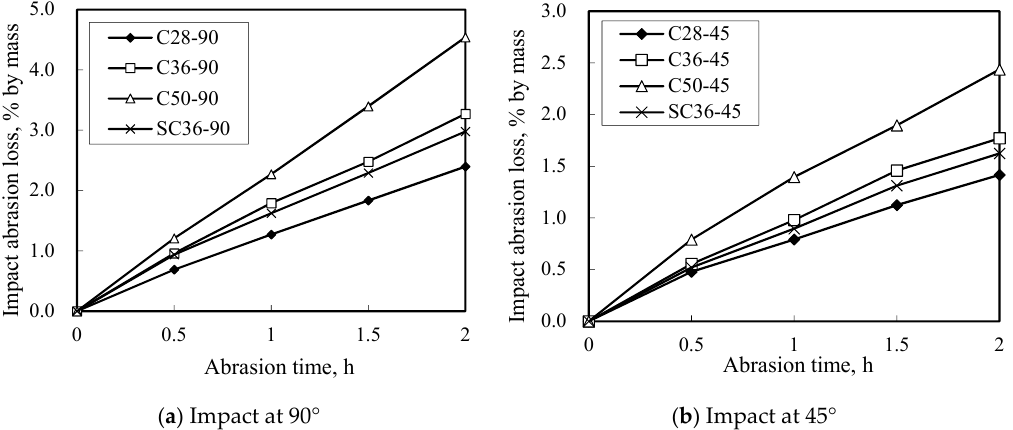
Figure 10. Impact abrasion loss of concrete.